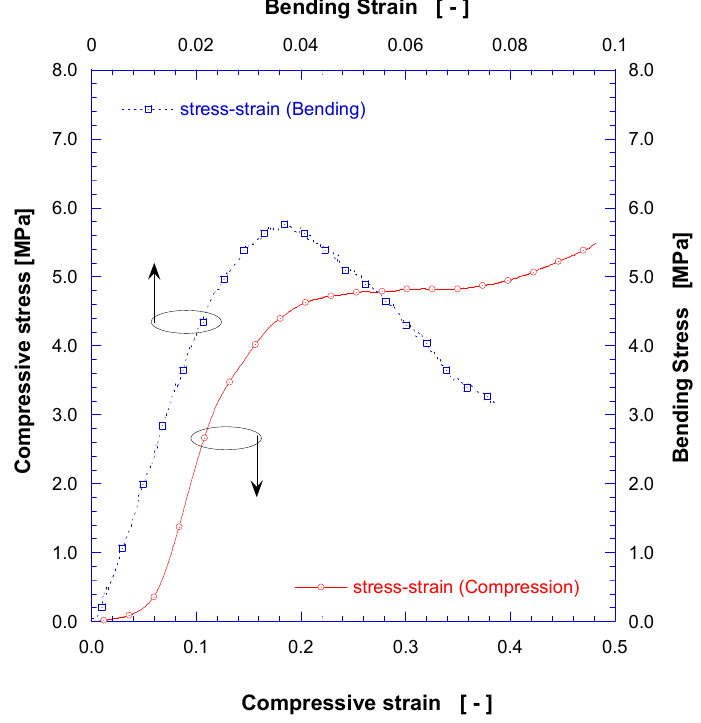
Figure 7. Bending and compressive stress-strain curves for PLA solid freeform before foaming process.